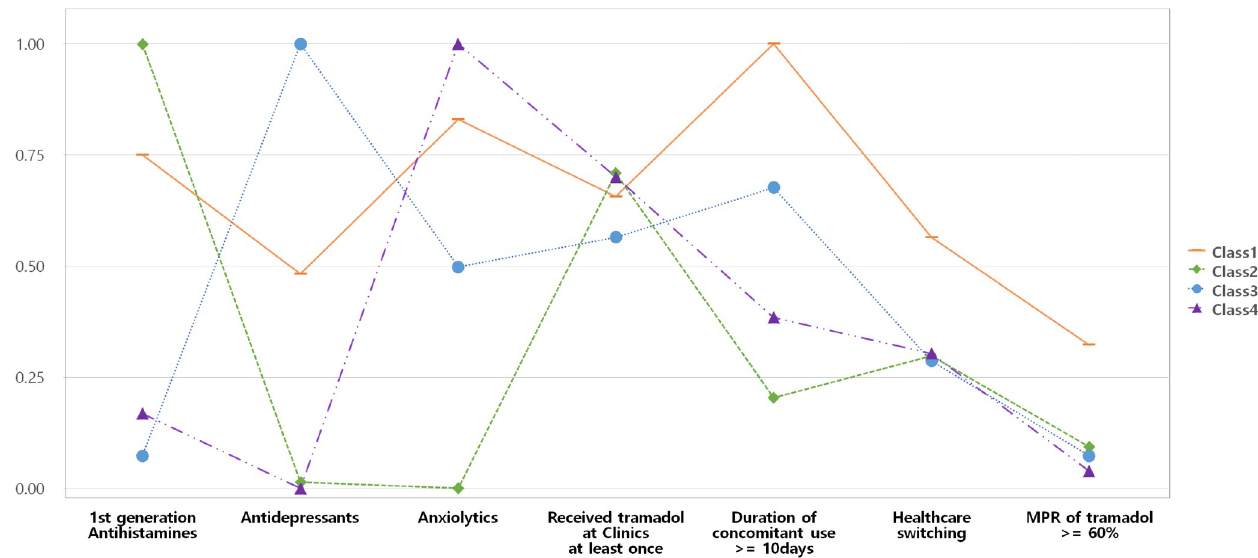
Fig 2. Class probability in the four latent classes of tramadol users with potential drug-drug interactions. � Class 1, multiple pDDI combination users; Class 2, antihistamines-tramadol users; Class 3, antidepressants-tramadol users; and Class 4, anxiolytics-tramadol users. MPR, medication possession